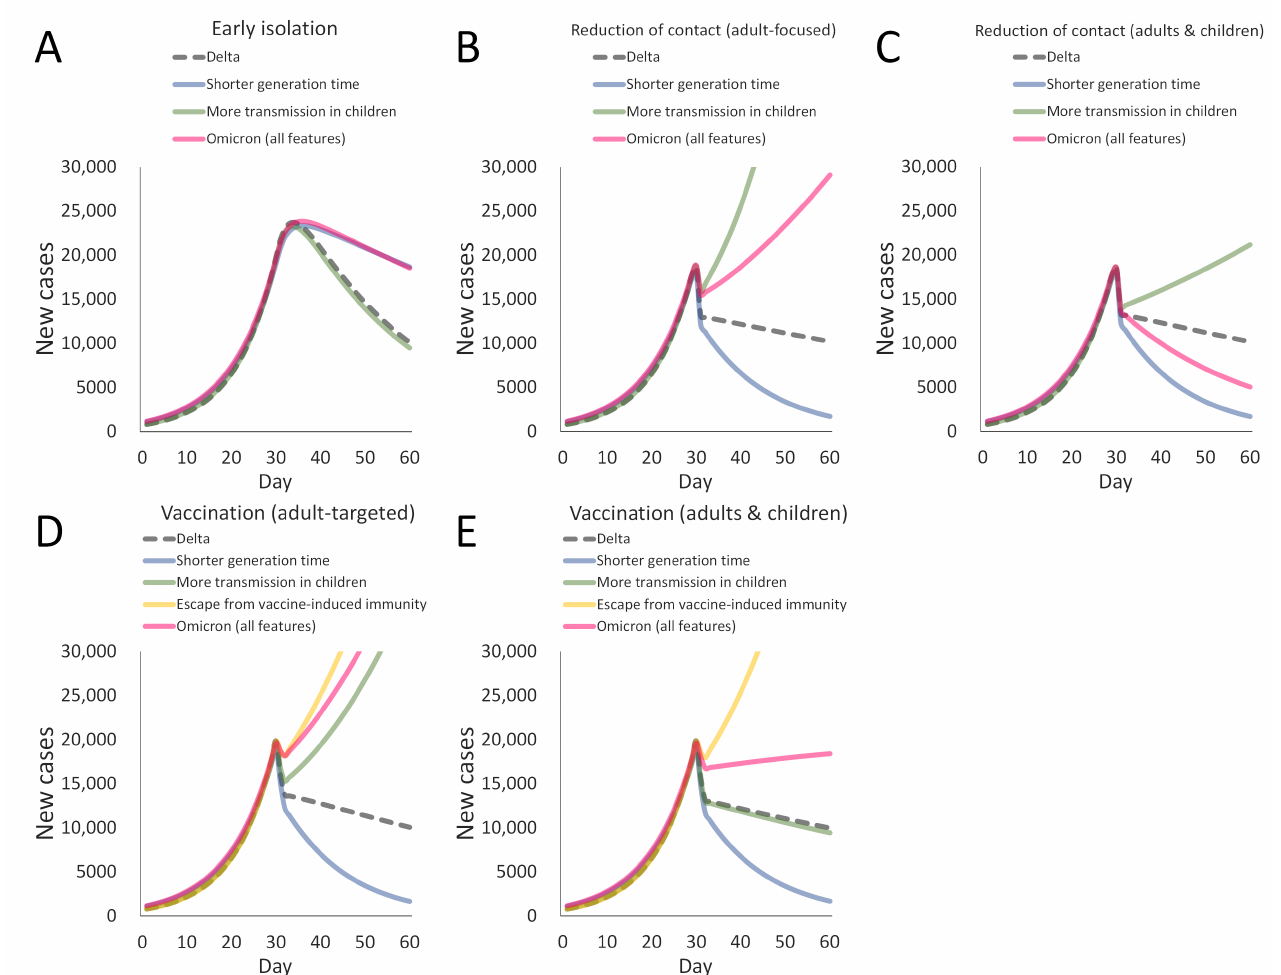
Figure 2. Influence of the properties of the Omicron variant on the effectiveness of public health interventions. The number of newly infected people in the 60-day simulation is shown in the figure. The infection spreads are adjusted to reproduce a similar situation for all scenarios by day 30. Thereafter, each intervention is implemented to reduce the number of new cases to the same degree for the Delta variant (black broken lines). Colored solid lines represent the number of new cases when a circulating virus acquires different properties of the Omicron variant. Analyzed interventions are ( A ) early isolation, ( B ) “adult-focused” reduction of contact, ( C ) “adults and children” reduction of contact, ( D ) “adult-targeted” vaccination, and ( E ) “adults and children”